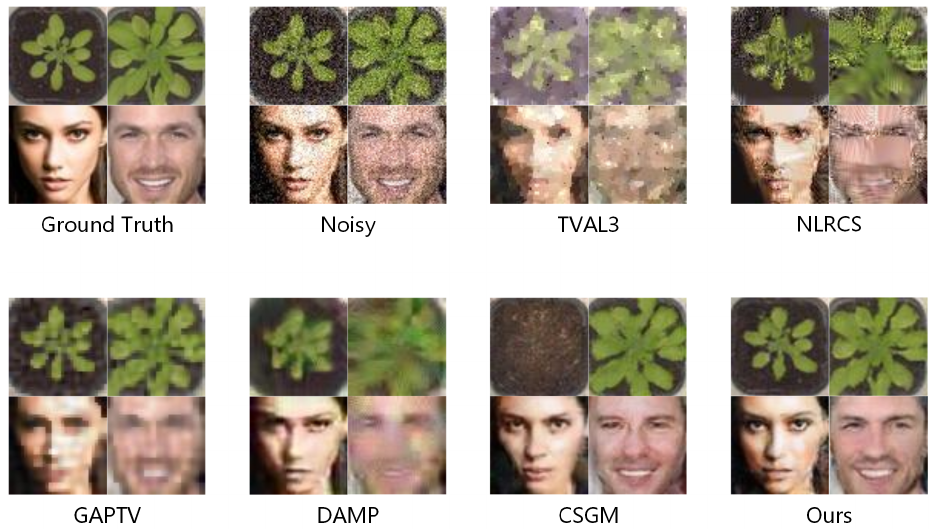
Figure 7. Some reconstruction samples of plant seedling and face images adding Gaussian noise with cr = 10 and σ = 0.2. The ground truth, noisy images, and images reconstructed by various methods are